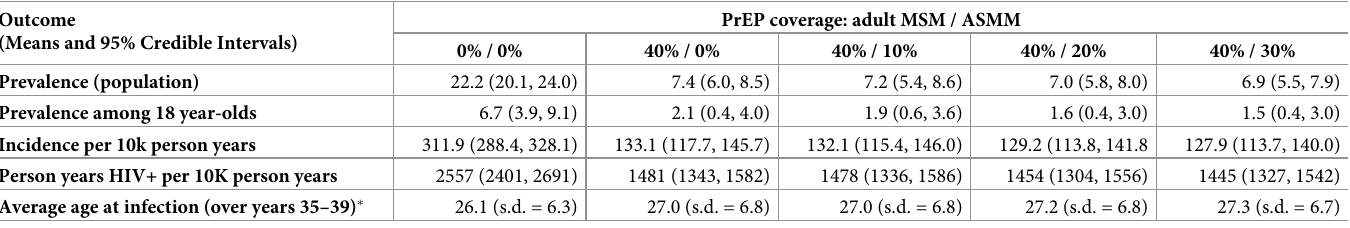
Average age at infection (over years 35–39)